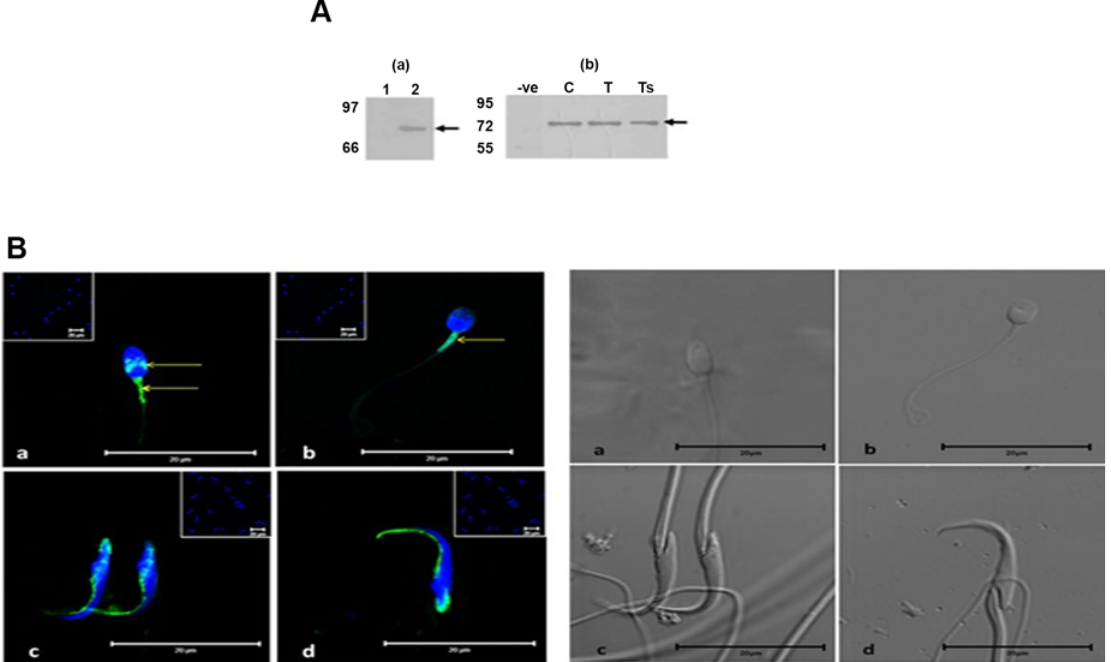
Fig 2. GRP78 expression in sperm. A) Western blot analysis of GRP78 in human sperm, rat testis, and rat testicular- and caudal- sperm. GRP78 expression in human sperm (a) [Lane 1: negative control], and rat sperm and testis (b) [-ve: Negative control, C: Caudal sperm, T: Testicular sperm, Ts: Testicular tissue] B) IIF localization of GRP78. In normal human sperm, GRP78 expression seen in the equatorial region of sperm head, neck and midpiece when non-permeabilized (a) and on neck and midpiece when permeabilized (b). In caudal (mature) rat sperm, GRP78 localization is observed in the equatorial region of sperm head when non-permeabilized (c) and on neck and anterior tip of sperm head on permeabilization (d) (Left panel). Inset shows the negative control for the respective images. DIC images of the respective sperm (Right